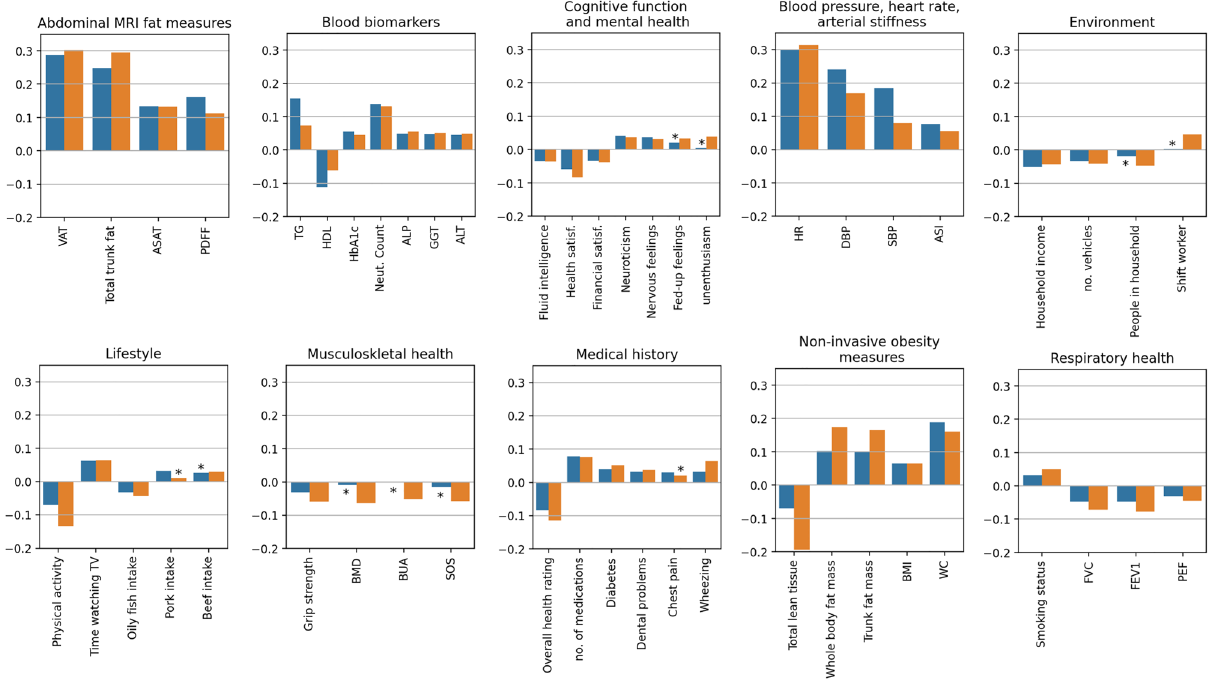
Figure 4. Selected results from the PheWAS. Results are Pearson correlation coefficients of exposures with heart age delta in men (orange) and women (blue). Positive correlations indicate exposures linked to greater heart age delta (accelerated heart aging) and negative correlations indicate exposures linked to smaller heart age delta (decelerated heart aging). Asterix indicates results that are not statistically significant (p-value * number of tests > 0.05). ALP: alkaline phosphatase; ALT: alanine aminotransferase; ASAT: abdominal subcutaneous adipose tissue volume; ASI: arterial stiffness index; BMD: bone mineral density; BMI: body mass index; BUA: bone ultrasound attenuation; DBP: diastolic blood pressure; FEV1: forced expiratory volume in 1 s; FVC: forced vital capacity; GGT: gamma glutamyl transferase; HbA1c: serum glycosylated haemoglobin; HDL: high density lipoprotein; HR: heart rate; LDL: low density lipoprotein; Neut: neutrophil; PDFF: Proton density fat fraction; PEF: peak expiratory flow; SBP: systolic blood pressure; TG: triglyceride level; TV: television; VAT: visceral adipose tissue volume; WC: waist circumference. Please note, for “health satisf.” “financial satisf.”, and “overall health rating” variables, the UK Biobank standard coding tables allocate higher score to poorer ratings, here